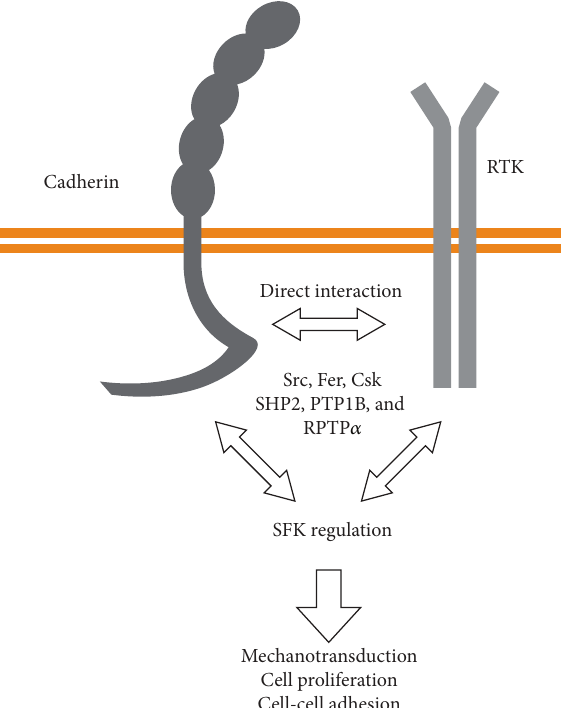
Figure 2: Cadherins can regulate PTK activity. The proposed mechanisms include the direct modulation of kinases and phosphatases as well as interactions with receptor tyrosine kinases. Cadherin-mediated PTK activity has been shown to be involved in mechanosensory transduction, contact inhibition of cell proliferation, and strength of cell